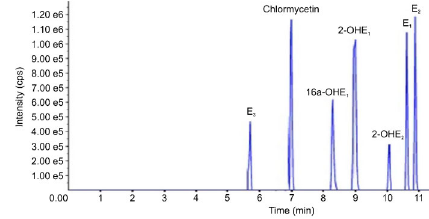
Figure 4. Total ion flow chart. E 1 : estrone; E 2 : estradiol; E 3 : estriol; 2-OHE